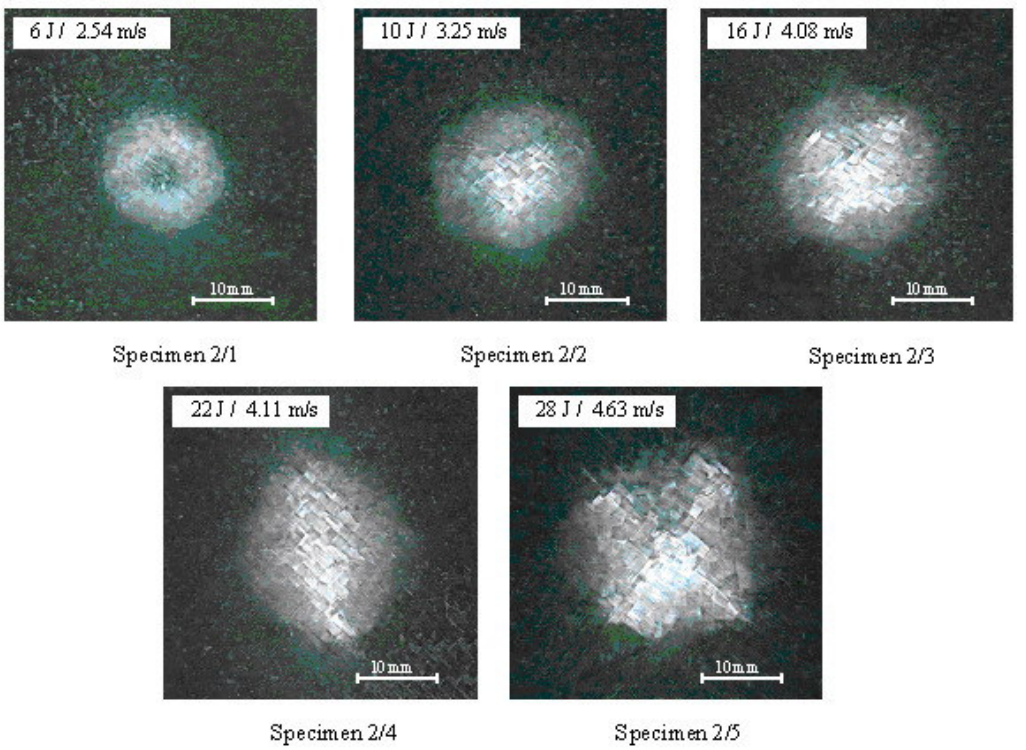
Fig 5. Back face view of woven glass-fiber reinforced composites showing damage modes at respectively damage and failure at higher energies. At the very low linear trends are not strong. The limiting of maximum impact energy of about 6 J obtainable damage is visible. force due to fibre damage at high incident energies is observed.